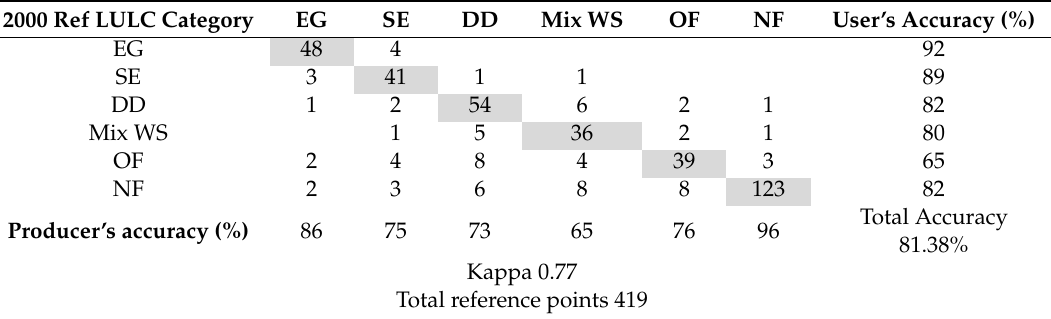
Table A8. Accuracy of the PBTC land cover map and referenced land cover map for